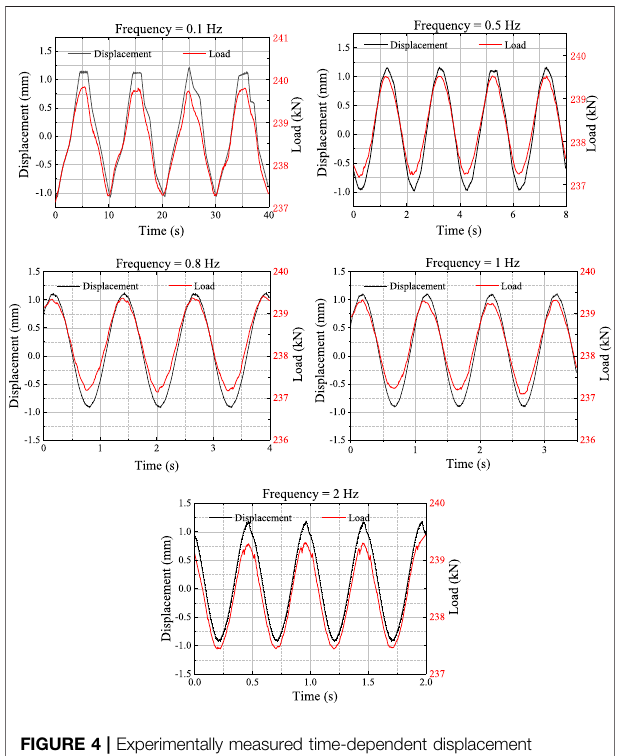
FIGURE 4 | Experimentally measured time-dependent displacement and load (the displacement in ±1 mm).